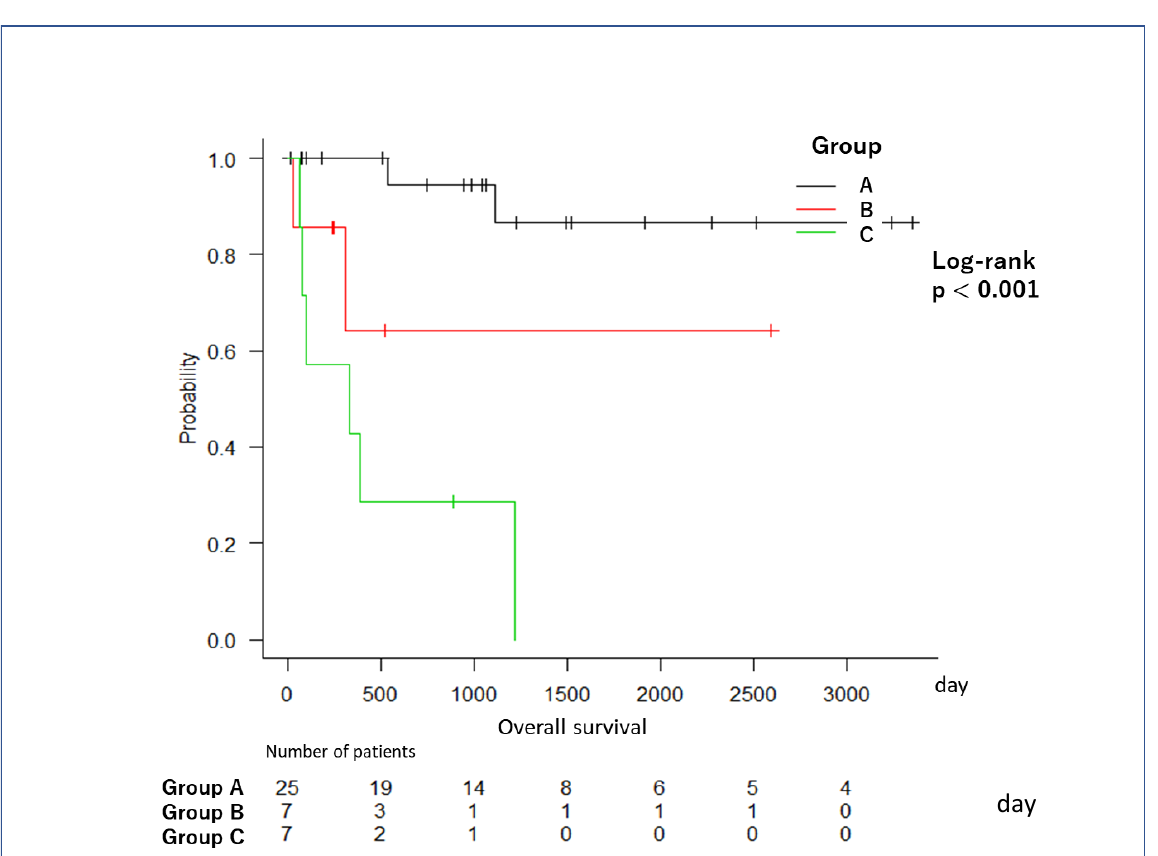
Figure 4. Kaplan–Meier curves showing overall survival in the three groups. There is a significant difference in overall survival between the three groups ( p ≤ 0.001). The median overall survival was not reached in Groups A and B and was 335 days in Group C (Figure 1). Patients in Group C showed the shortest overall survival among the three groups, while patients in Group A showed the longest overall survival.